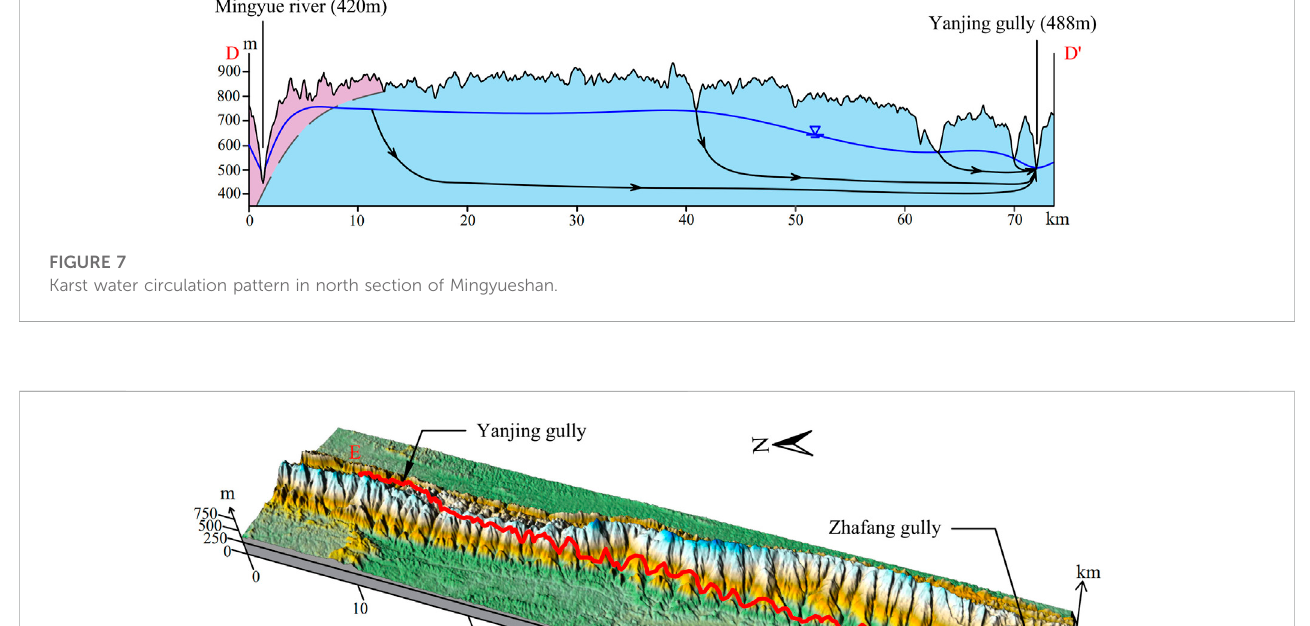
FIGURE 8 Karst water circulation pattern in middle section of